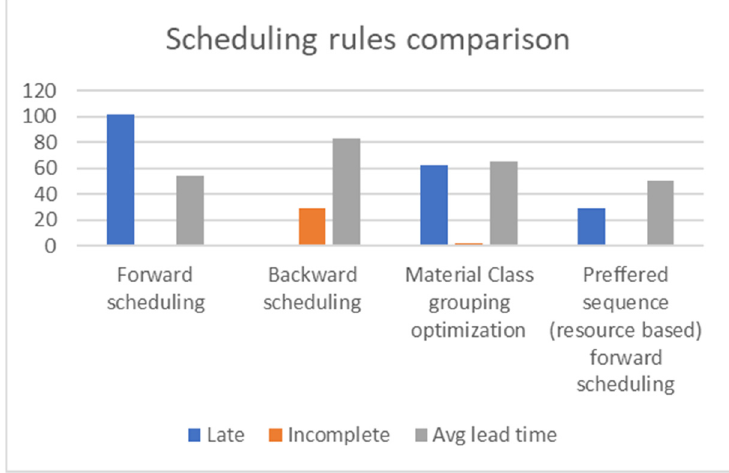
Figure 11. Comparison of scheduling operation-graphical.